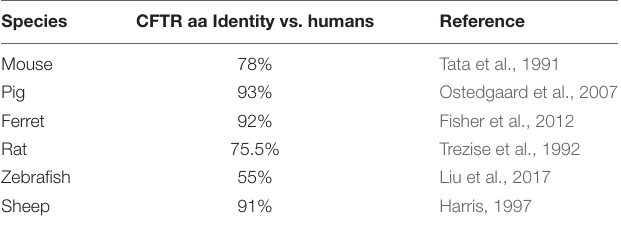
TABLE 1 | Amino acid identity in CFTR